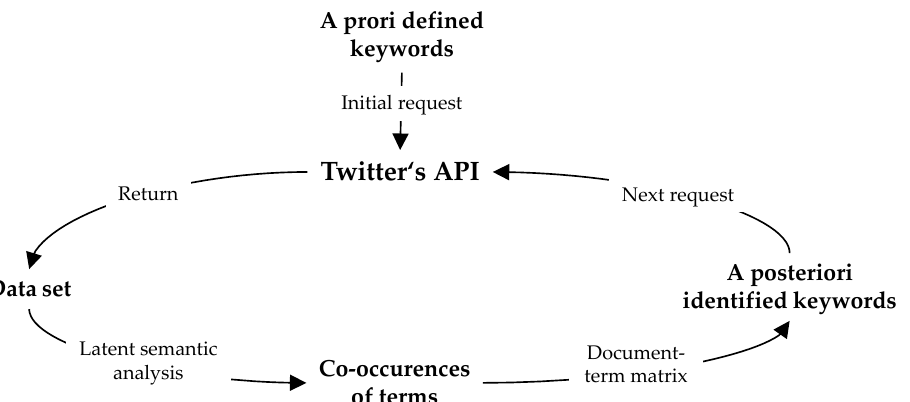
Figure 3. Request model for Information Retrieval (IR) of relevant tweets. The request was initially started with keywords derived qualitatively from past storm events. The loop request was stopped as soon as the top 5% of co-occurring terms were identical with the previously harvested